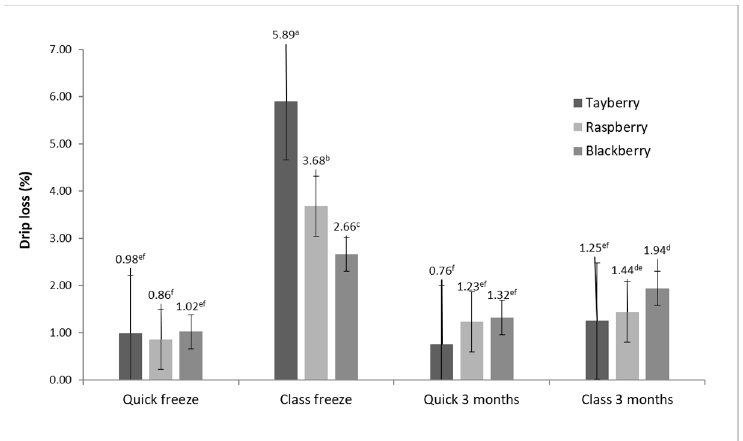
Figure 2. Drip loss of frozen berry fruits and after storage as a function of freezing method. Different letters indicate significant differences between mean values at p ≤ 0.0001. Significance of interaction: V × F–variety and freezing method p ≤ 0.2789; V × S–variety and storage p ≤ 0.1531; F × S–freezing method and storage p ≤ 0.0001; V × F × S–variety, freezing method and storage p ≤ 0.0001.